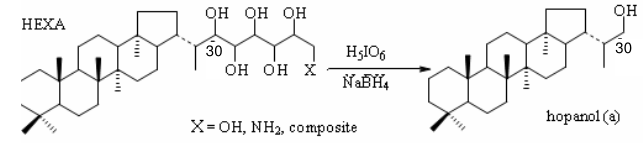
Figure 2. Periodic acid/sodium borohydride cleavage